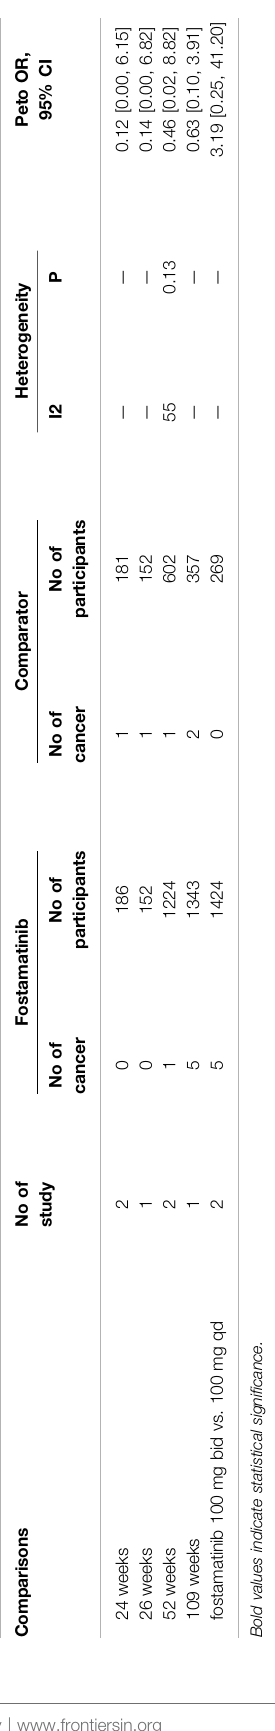
Compared to placebo, the use of fostamatinib did not have a higher benign neoplasm risk (Peto OR = 1.71, 95%CI 0.26 – 11.36, I 2 = 0, 4/2038 vs. 1/967, and n = 6) ( Table 2 , Supplementary Figure S13 ). A longer duration of fostamatinib use did not increase the risk of benign neoplasms 2 ; Supplementary Figure S13 ). Compared to 150 mg of fostamatinib once daily, 100 mg of fostamatinib twice daily did not elevate the risk of benign neoplasms (Peto OR = 0.41, 95%CI 0.10 – 1.57, I 2 = 0, 6/2954 vs. 5/1339, and n = 7) ( Table 2 ; Supplementary Figure S14 ). Similarly, long-term use of 100 mg of fostamatinib twice daily did not increase the risk of benign neoplasms ( Table 2 ; Supplementary Figure S14 ). In total, two studies reported a benign neoplasm risk in RA patients treated with different dosage times of fostamatinib. For T A